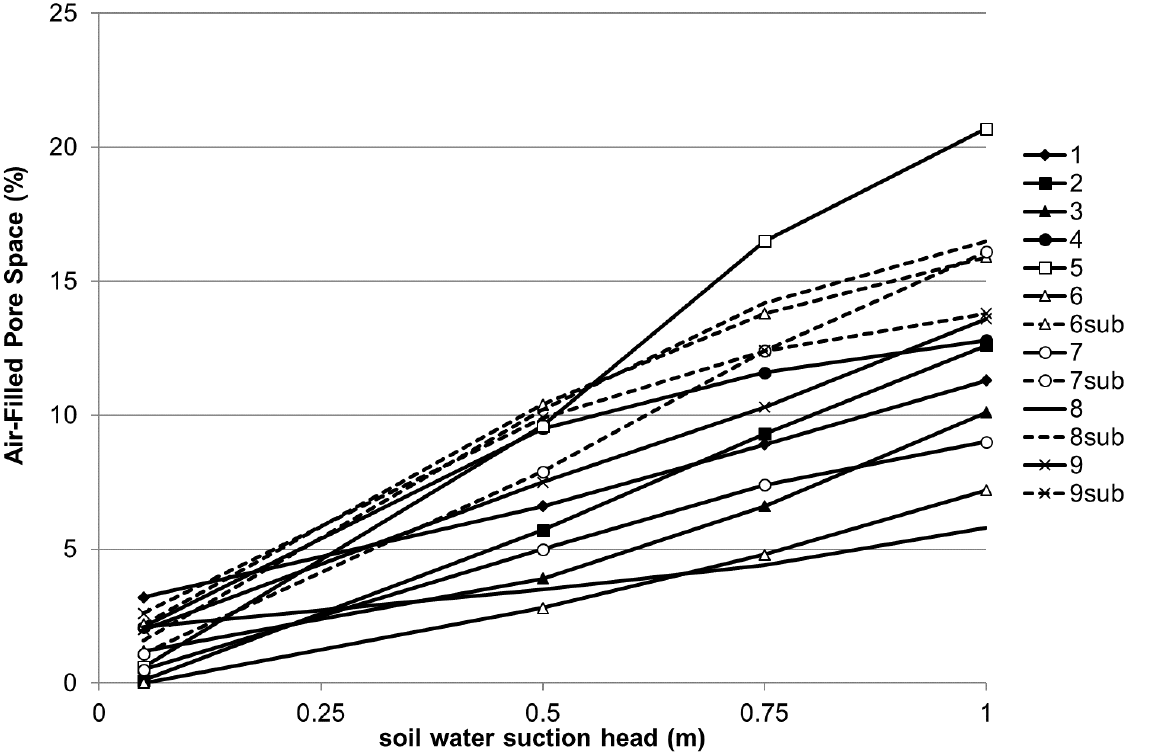
Figure 4. Air-filled pore space (%) for the 13 soils at suction heads of 0.05 (near water-saturated), 0.5, 0.75 and 1.0 m water column ( n = 3). Data for topsoils are indicated by solid lines and those for subsoils (Sites 6–9 only) by dashed